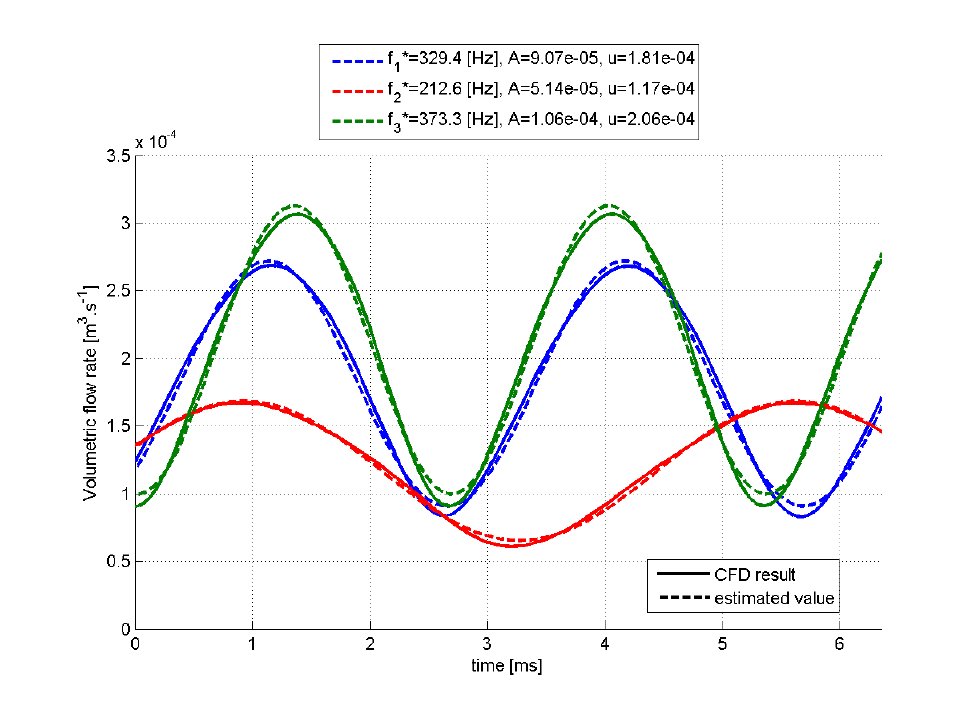
Figure 10. Volume flow rates—calculated and prescribed by the boundary condition model—for three different SaOB working